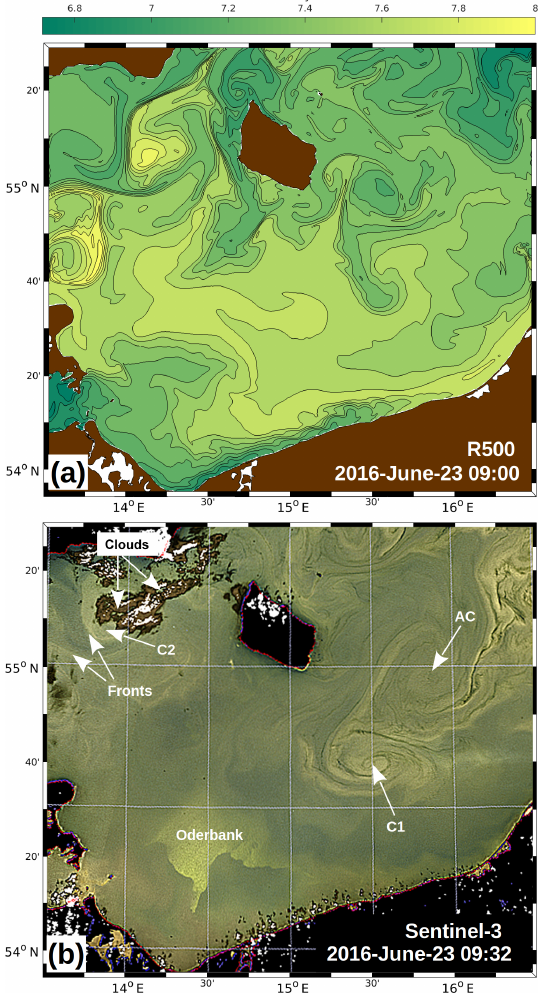
Figure 4. (a) Top-layer salinity of the R500 model on 23 June at 09:00. (b) RGB composite from the Ocean and Land Colour Instru- ment of ESA satellite Sentinel-3 for the R500 domain on 23 June at 09:32. The original image was manually adjusted in order to fit the Mercator projection used in (a) . C1, C2, and AC refer to the signatures of cyclonic and anticyclonic eddies, respectively. For the Oderbank; see Fig.